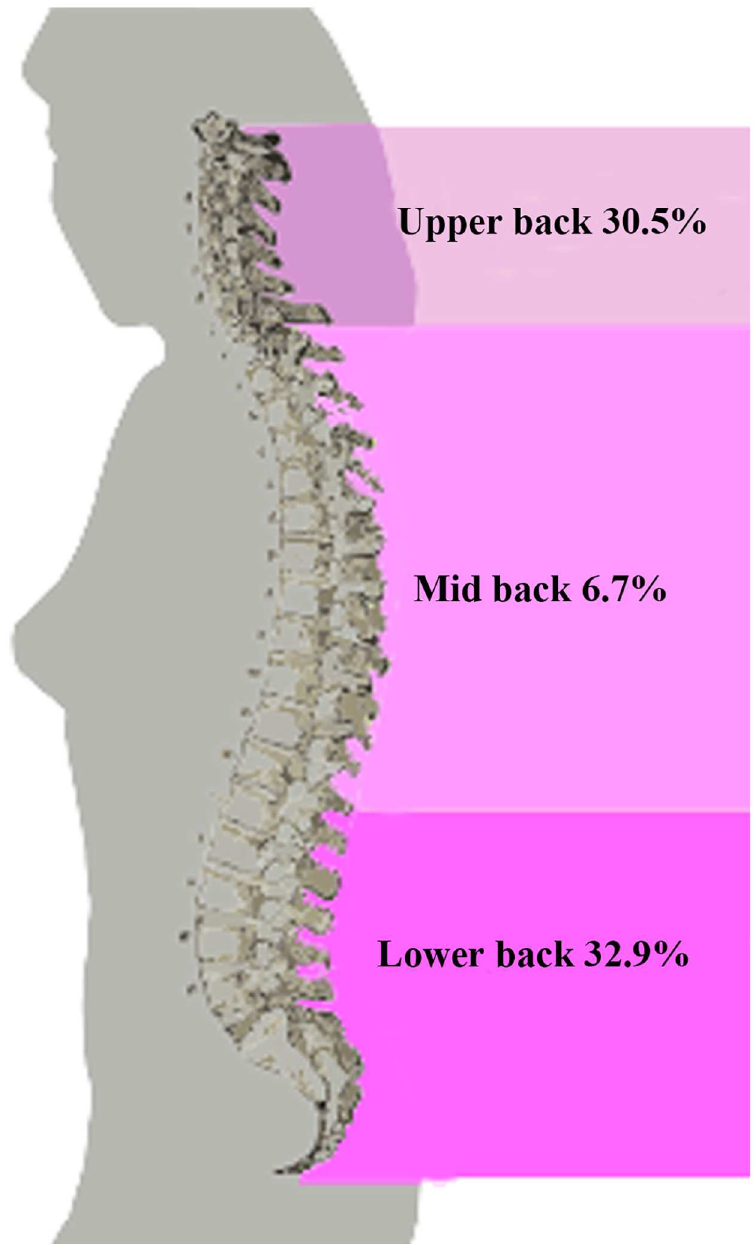
Fig 1. Baseline prevalence (percentage) of different types of back pain in the 210 study